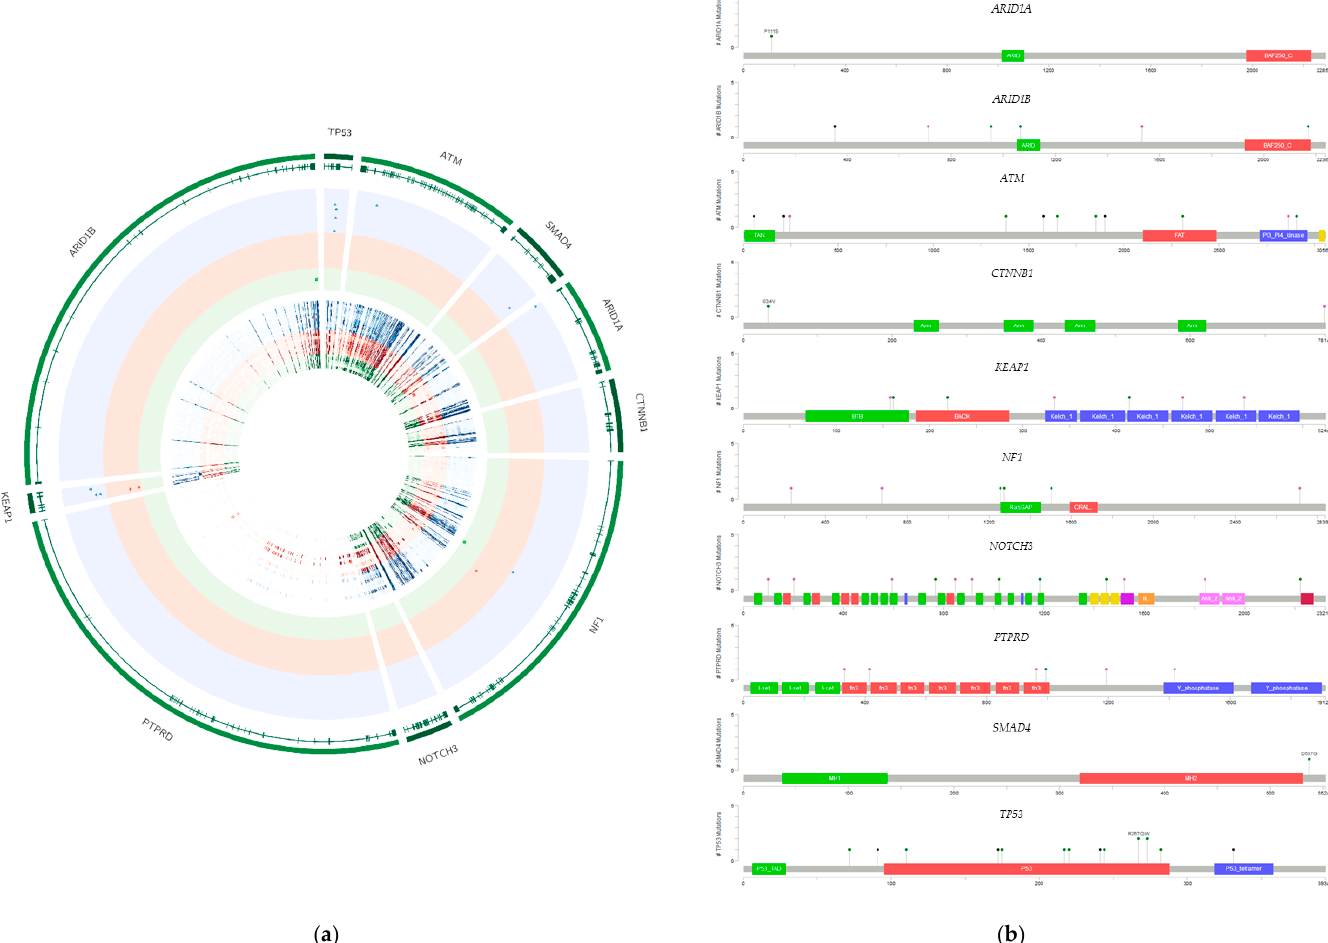
Figure 1. Circos plot of exonic mutations in the investigated hepatobiliary cancer cell lines (panel A) and their visualization using MutationMapper (panel B). ( a ) The tracks in the Circos plot show (1) the names of the genes with a mutation frequency of at least 10% in primary GBC tumors from MSK-IMPACT, (2) the genomic